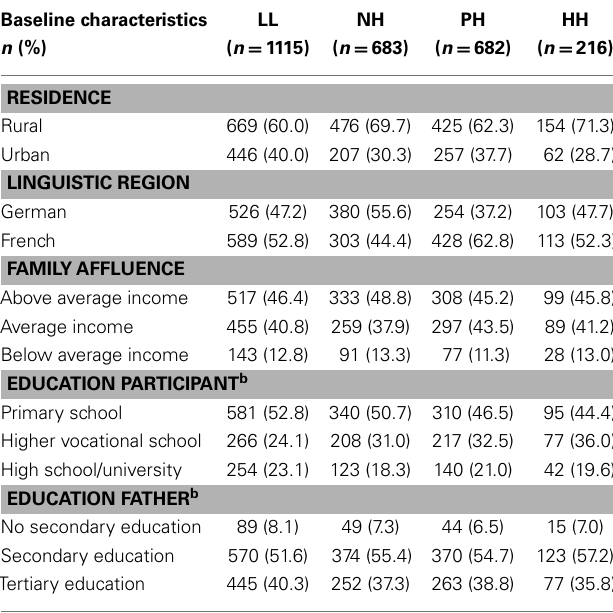
Table 2 | Baseline characteristics of the four drinking profiles a by drinking location .